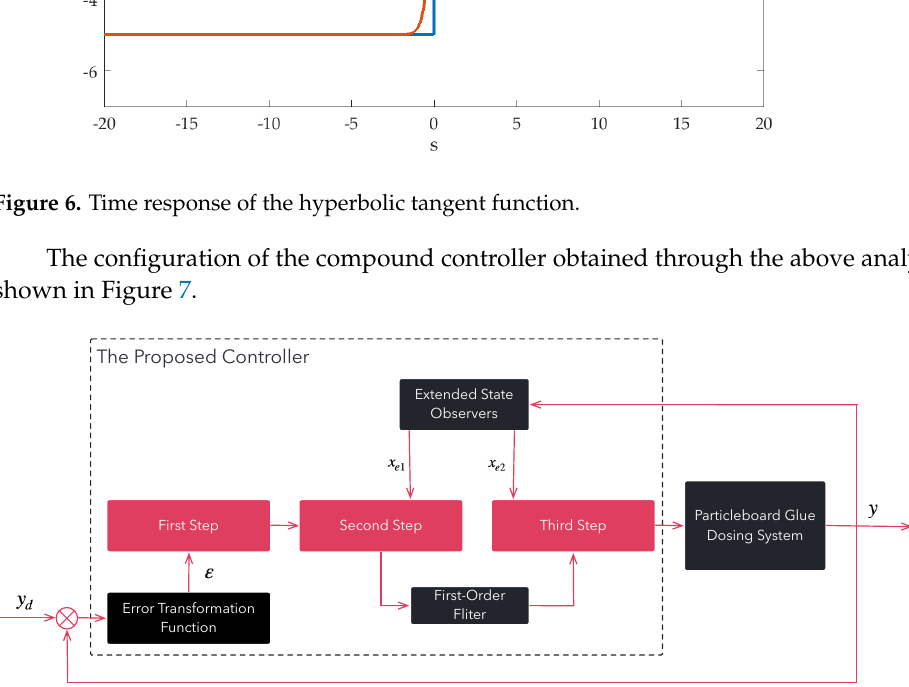
Figure 7. The configuration of the compound